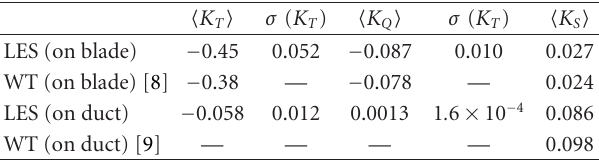
Table 5: Statistics of unsteady loads for the ducted propulsor at J = − 0 .